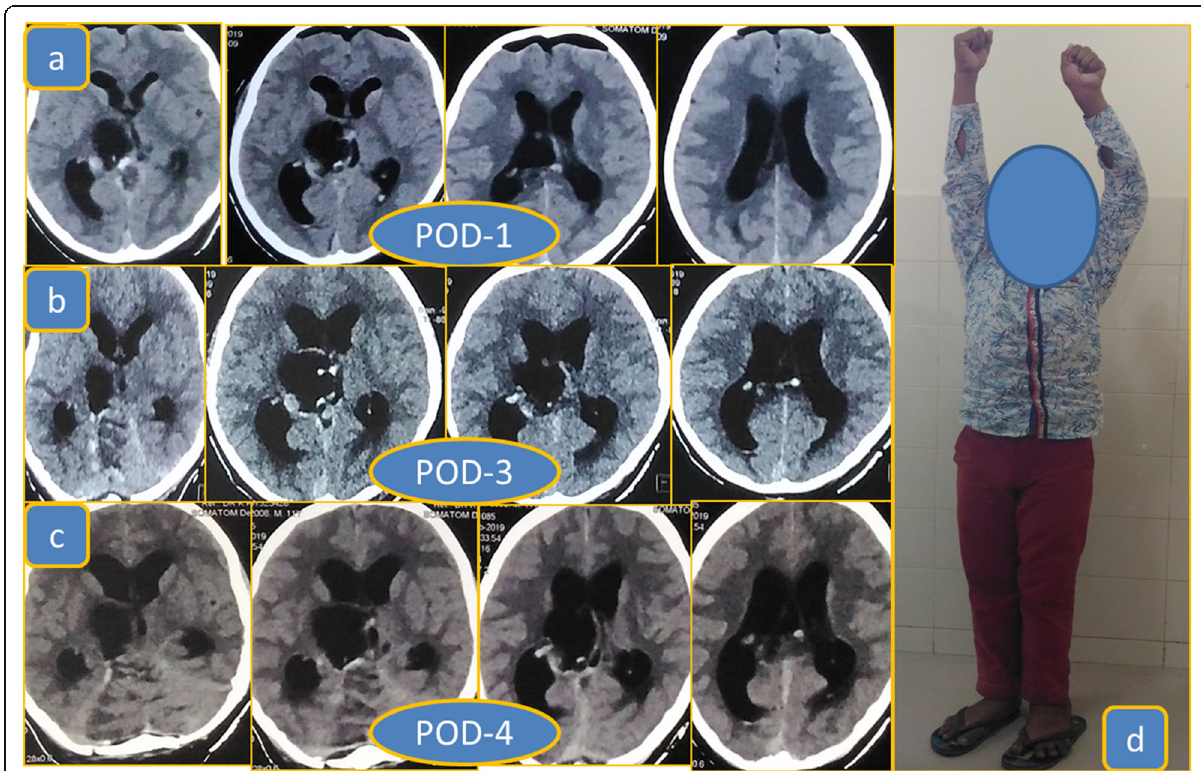
Fig. 2 a Postoperative NCCT head on postoperative (POD) 1 showing minimal pneumocephalus, clear operative cavity, mild ventriculomegaly, and no periventricular ooze. b, c Post-operative NCCT head on POD days 3 and 4 showing good and communicating operative cavity without any hematoma, with mild ventricle dilatation, without any periventricular ooze. d Showing postoperative image of the patients in standing position with improved power in the left upper